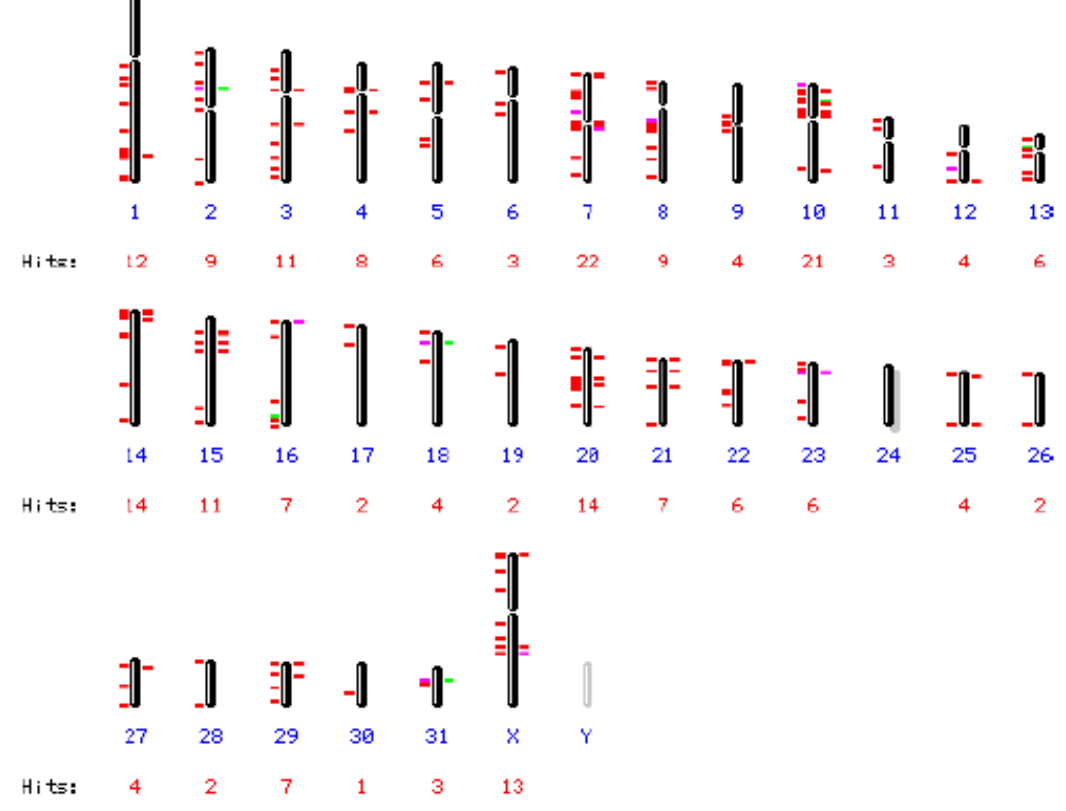
and pol are respectively 614, 317 and 870 amino acids. Because the gag-pro-pol gene is translated